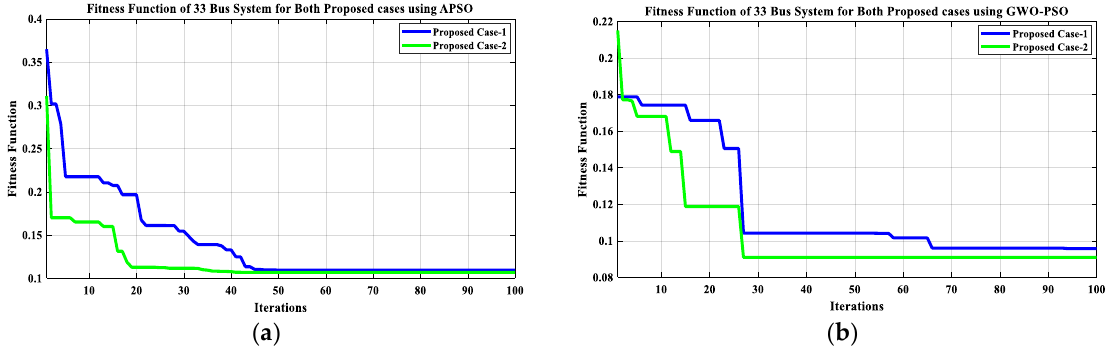
Figure 16. Reliability indices with system reliability of the 33-bus RDN; ( a ) APSO, ( b ) GWO-PSO.